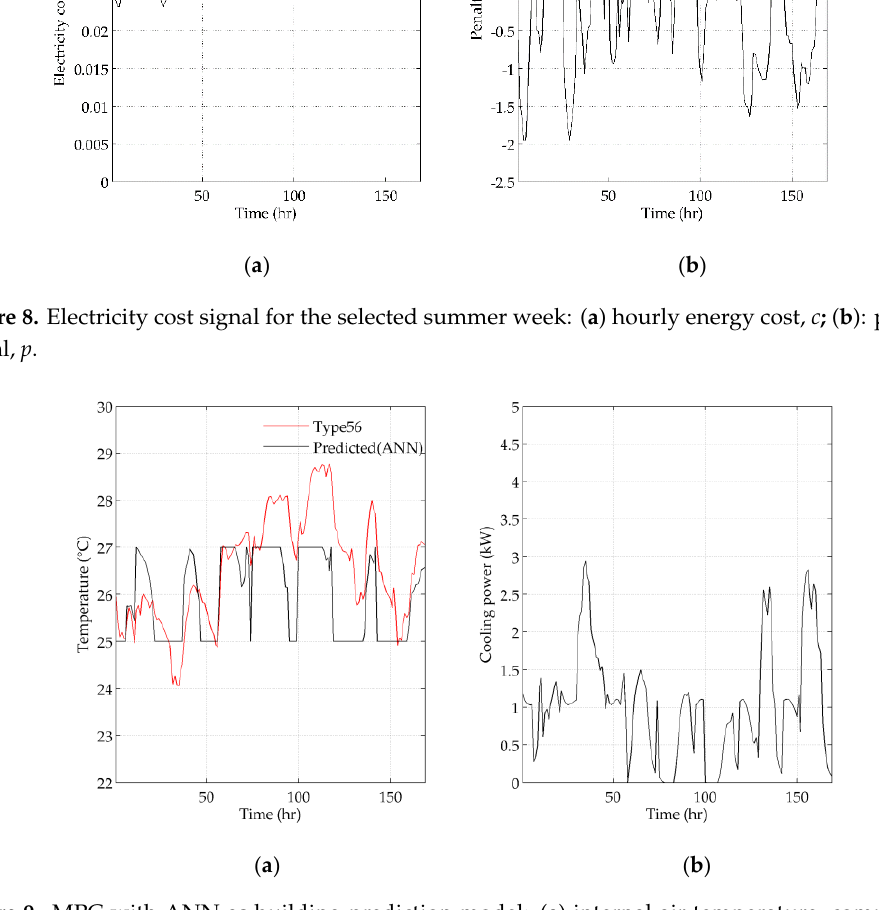
( a ) ( b ) Figure 10. MPC with RC as building prediction model: ( a ) internal air temperature, comparison between the actual Type 56 air zone temperature, and RC prediction at each timestep; ( b ) cooling power profile (control action sequences). Figure 11. Indoor air temperature duration curves.